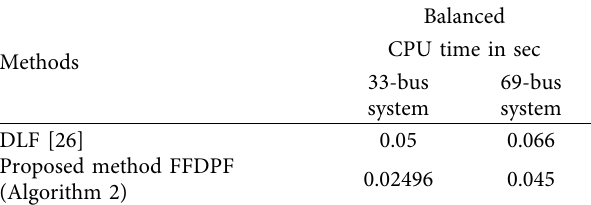
Table 2: Comparison of the CPU execution time of the balanced 33-bus and 69-bus